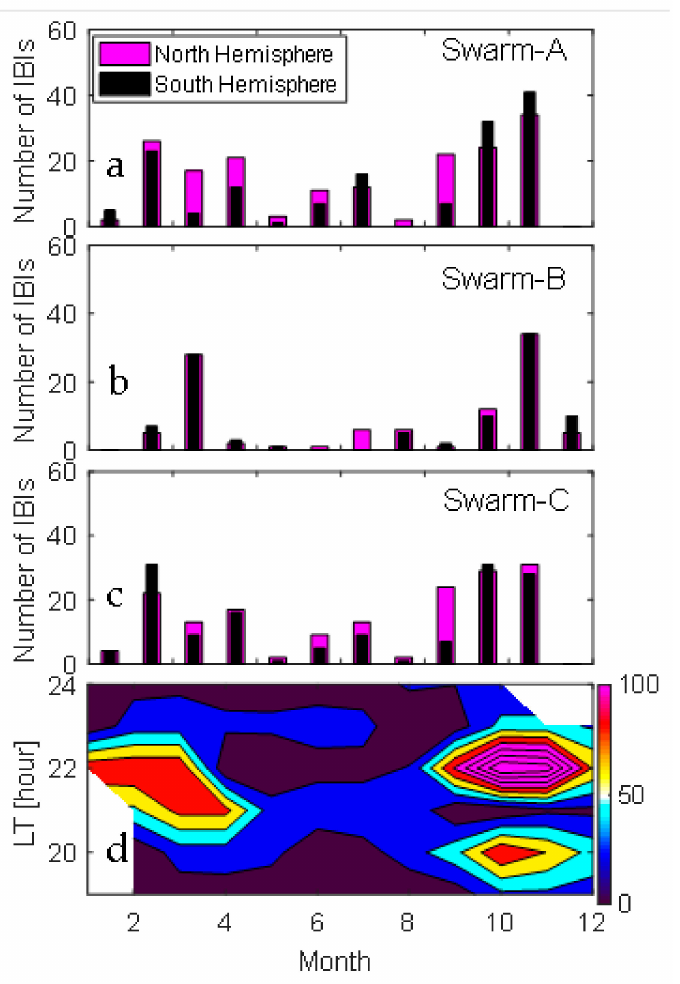
Figure 7. The number of IBIs observed in each month in the northern and southern hemisphere in magenta and black bars, respectively, at the altitudes of ( a ) Swarm A, ( b ) Swarm B, and ( c ) Swarm C. ( d ) a contour map of the local time with respect to months for the number of